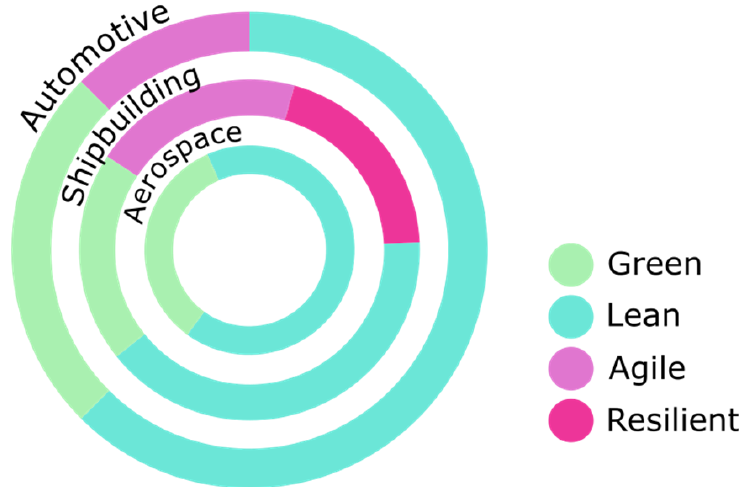
Figure 6. Sustainable Supply Chain-driving methodologies.